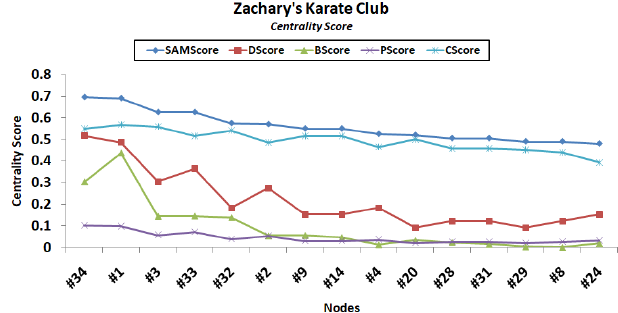
Figure 6. Ranking of top 15 nodes from Dolphin dataset, sorted by SAM centrality